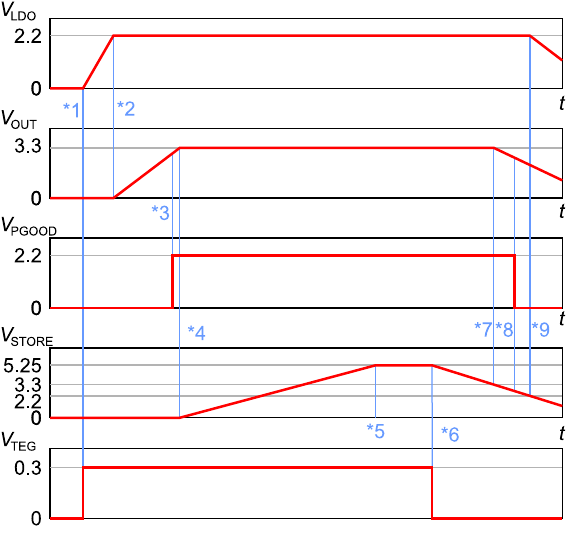
Figure 8. Output voltage sequences for input ( V TEG ), storage ( V STORE ), outputs ( V LDO , V OUT ) and status ( V PGOOD